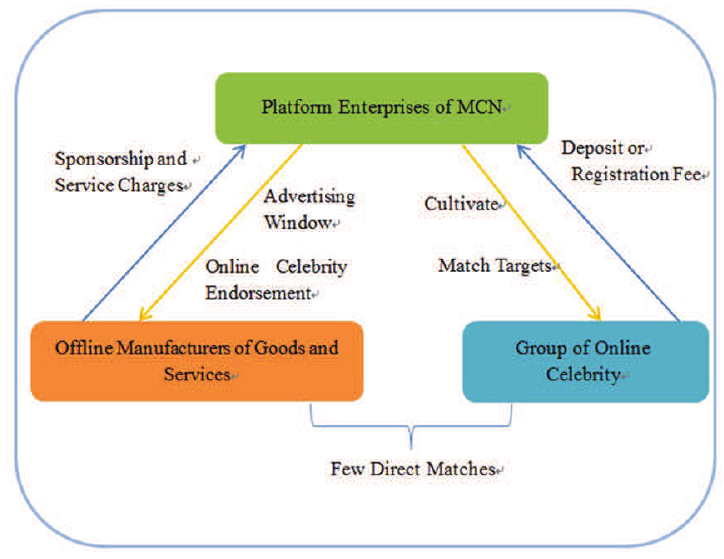
Fig. 1 The structure of two-side market in online celebrity